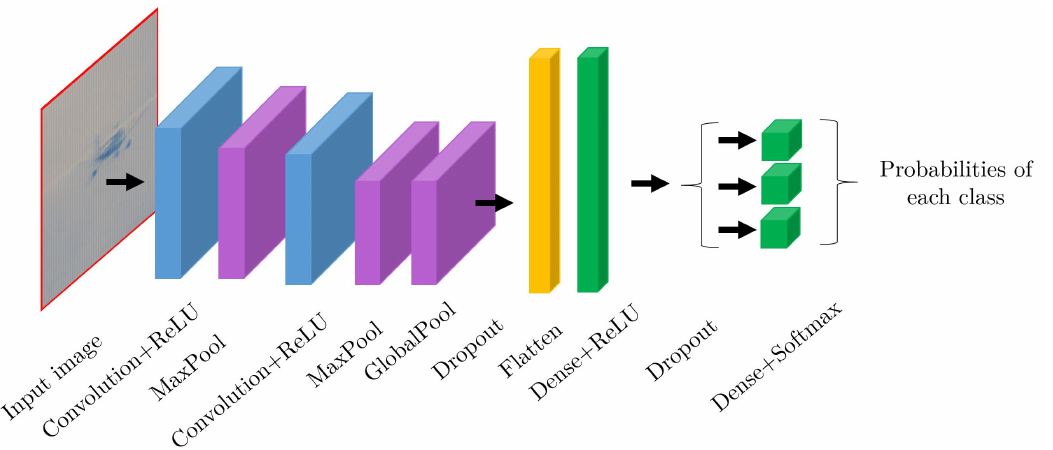
Figure 6. Convolutional neural network